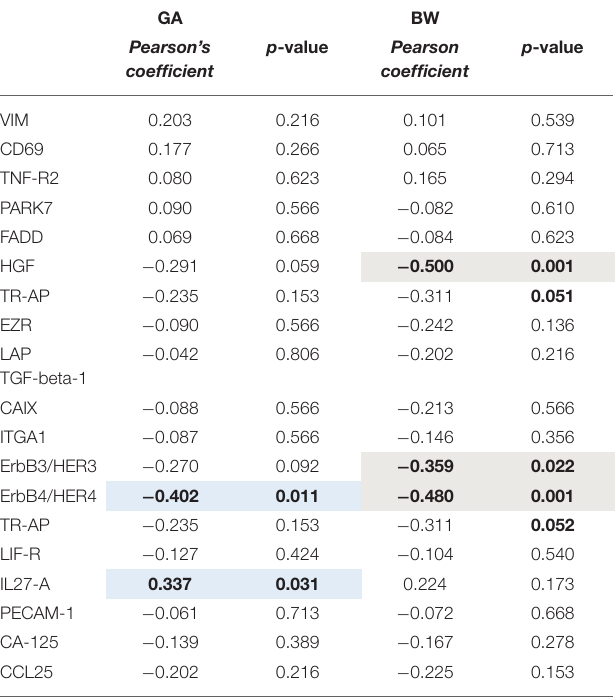
TABLE 3 | Correlations between biomarkers ( n = 18) and GA or BW. GA